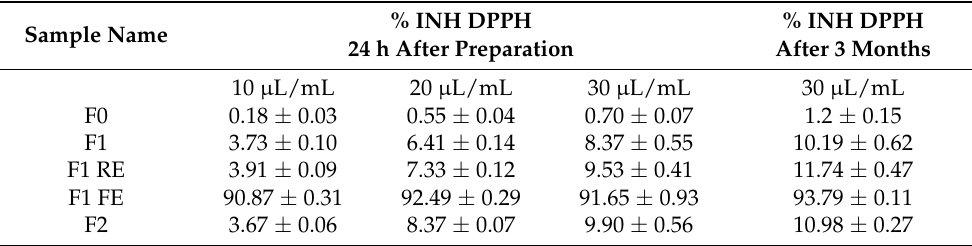
Table 3. Antioxidant activity expressed as a percentage of inhibition (% INH) of DPPH free radical of the selected nanoemulsions at different concentrations 24 h after preparation, and after 3 months of storage at room